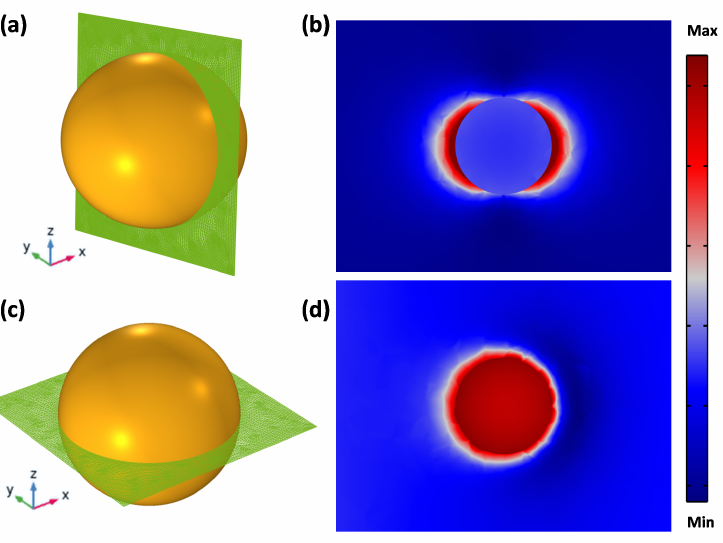
Figure 5. Cutting planes of individual Au NPs, parallel ( a ) and perpendicular ( c ) to the polarization field, and their respective E-field enhancement ( b , d ) distributions.